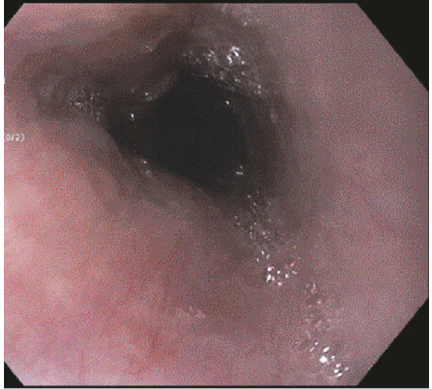
Figure 2: Follow-up EGD 3 weeks after hospital discharge showing normal mucosa in the middle to lower third of